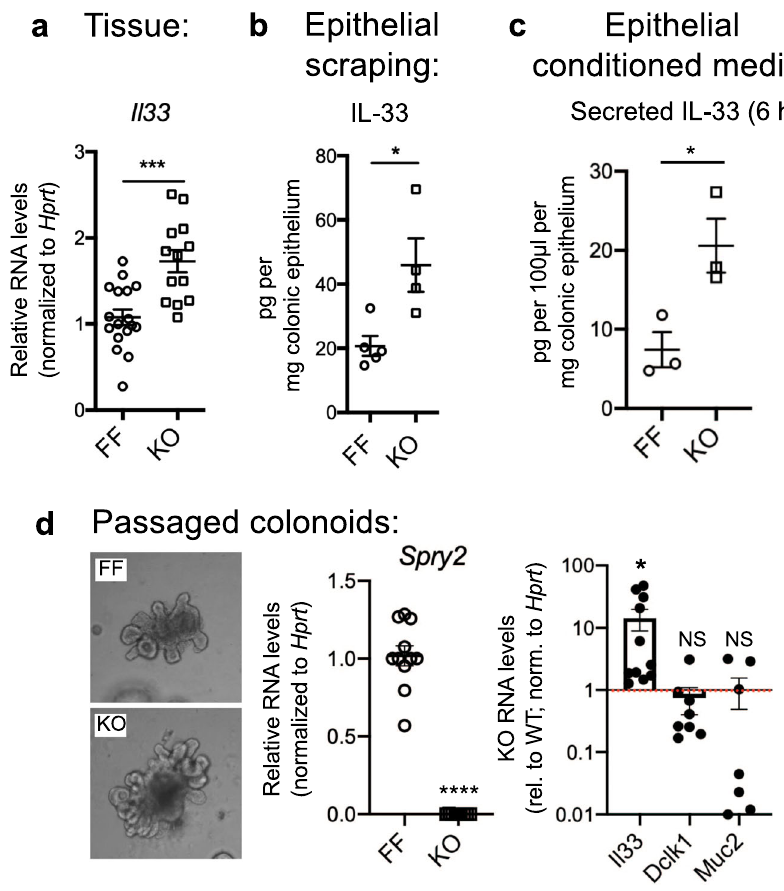
Fig. 3 Colonic epithelial IL-33 expression is increased in Spry2 IEKO mice. a Il33 expression was measured by qPCR in colonic homogenates from Spry2 FF and Spry2 IEKO mice ( n = 17 FF, 13 KO; *** p = 0.0002). b IL-33 protein was measured in colonic epithelial scrapings by ELISA ( n = 5 FF, 4 KO; * p = 0.0172). c Secreted IL-33 was measured in conditioned media from epithelial peels after 6 h incubation by ELISA ( n = 3 per group; * p = 0.0314). d Expression of Spry2 ( n = 11 FF, 9 KO cultures; **** p < 0.0001), Il33 ( n = 11 cultures; * p = 0.0221) , Dclk1 ( n = 8 cultures), and Muc2 ( n = 7 cultures) was assayed by qPCR in passaged colonoids generated from Spry2 FF and Spry2 IEKO mice. Il33 , Dclk1 , and Muc2 expression in Spry2 IEKO is presented relative to Spry2 FF mice (indicated by red dashed line n = 11 cultures). In fi gure, each colonoid culture was generated from a separate mouse and data are presented as mean ± SEM. Analyzed by two-sided t